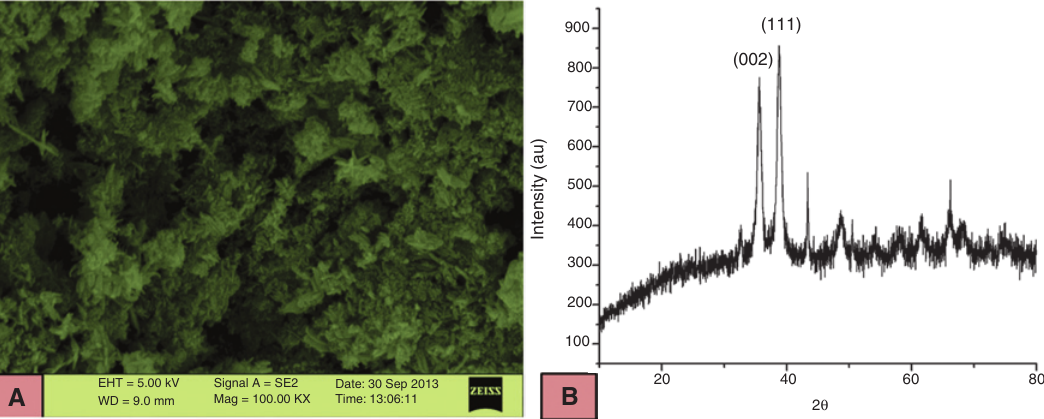
Figure 4: (A) Scanning electron microscopy (SEM) micrograph of CuO nanoparticles (NPs) at 100.00 KX; (B) X-ray diffraction pattern of CuO